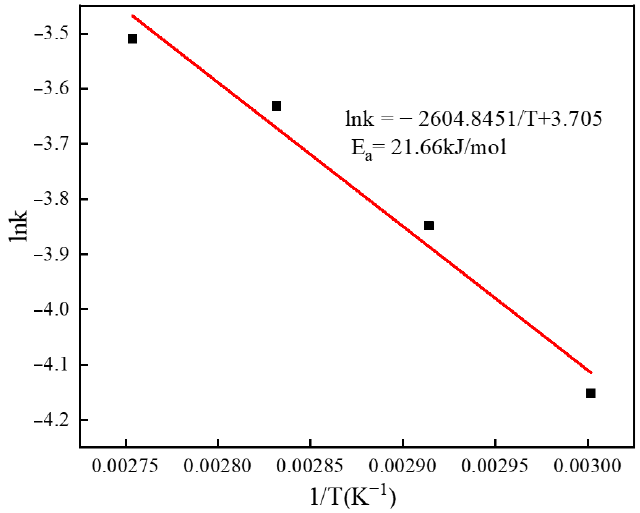
Figure 11. Linear fit of lnk vs 1/T for the leaching reaction kinetic